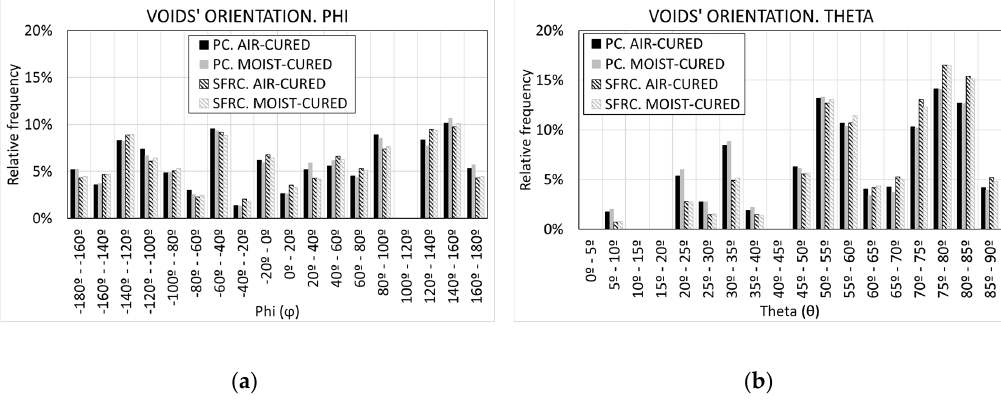
Figure 13. Voids’ orientation: ( a ) phi and ( b ) theta.